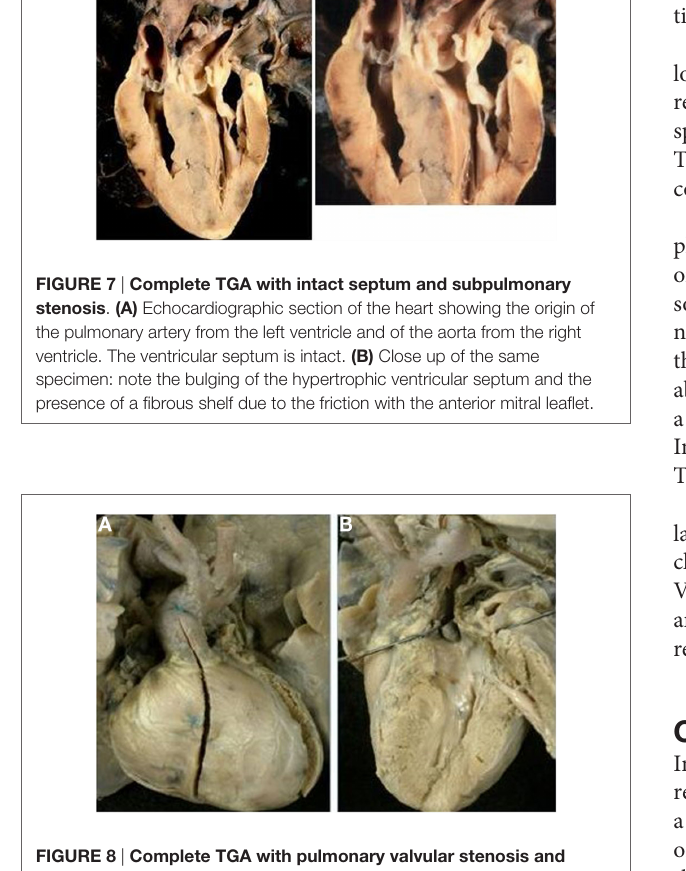
FigUre 8 | complete Tga with pulmonary valvular stenosis and small VsD . (a) External view of the heart with right anterior position of the aorta. (B) View of the left outflow tract: note the subpulmonary stenosis due to the deviation to the left of the infundibular septum and the presence of unicuspid and dysplastic pulmonary